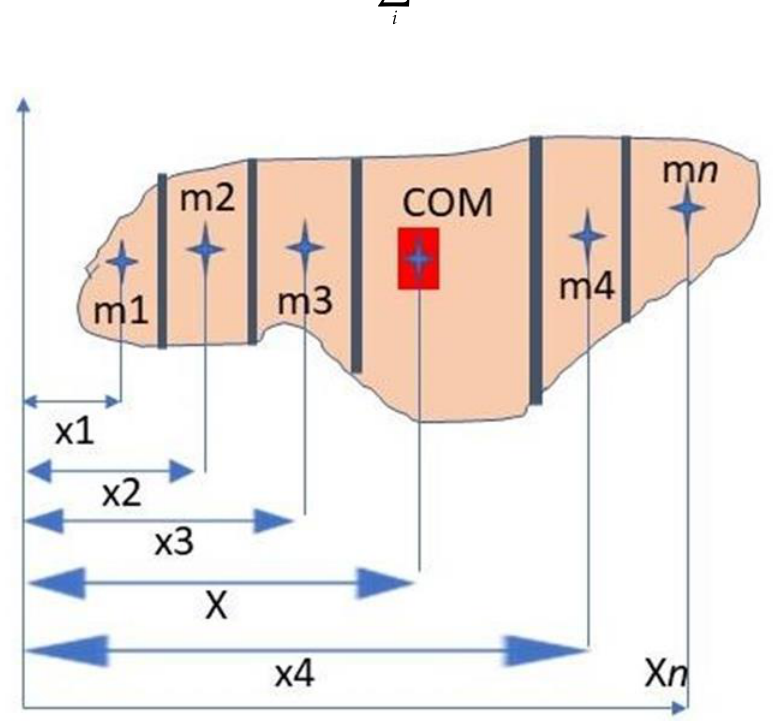
Figure 2. Localization of the center of mass (COM) off an object by means of the segmental method. Equation (1). x is the horizontal location of the total body center of mass, n is the total number of segments, m 1 is the mass of the i th segment, M is the total body mass, and x 1 is the horizontal